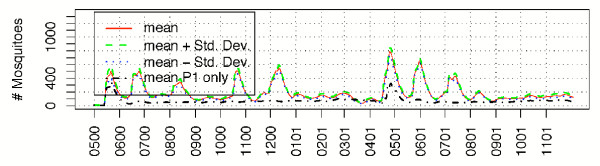
An. gambiae adult abundance with all three pools (P1, P2 and P3) mean of 20 simulations